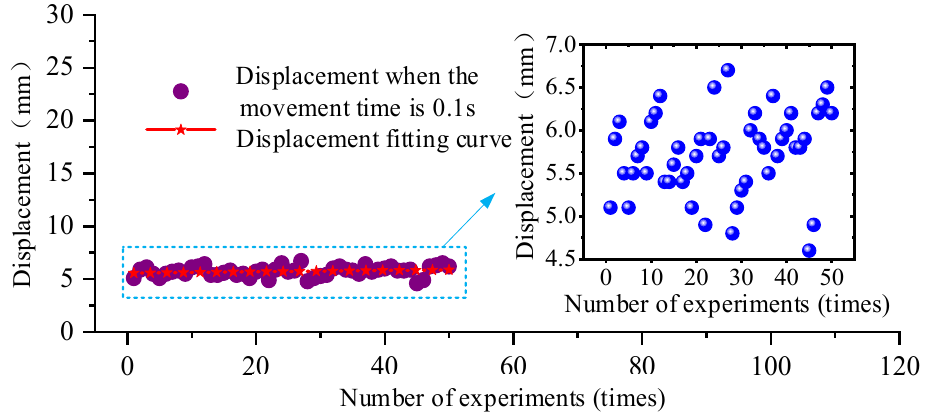
Figure 19. Variation curve of displacement with time during retraction of the pushing cylinder of hydraulic support.